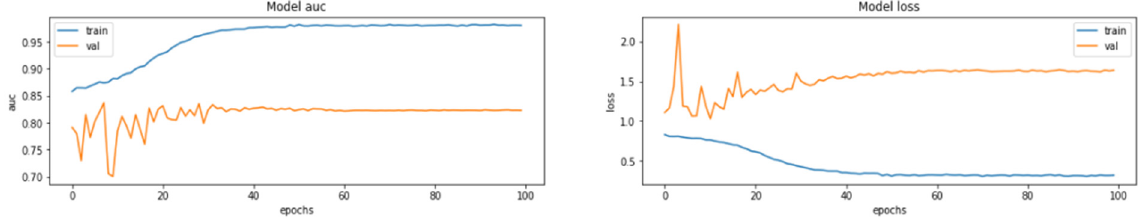
Figure 9. The AUC score for the train set was measured to be 0.9804, and the AUC score for the test set was measured to be 0.8232.